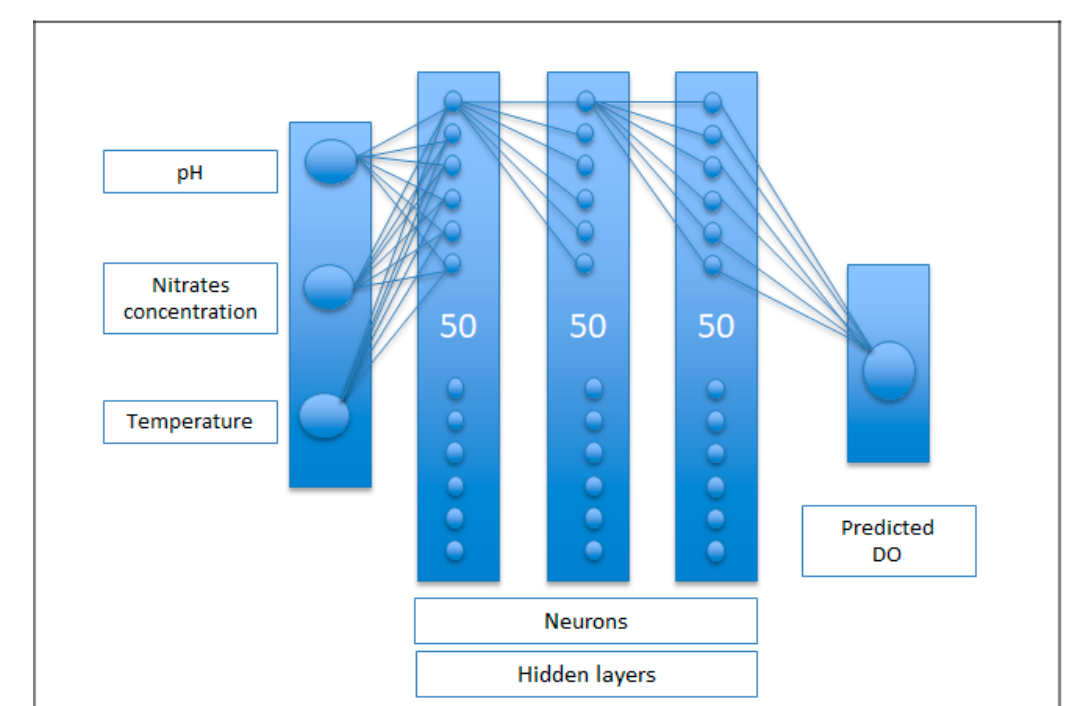
Figure 4. ANN architecture proposed for the prediction model of the DO present in the waters of the mouth of the El Albujón watercourse.